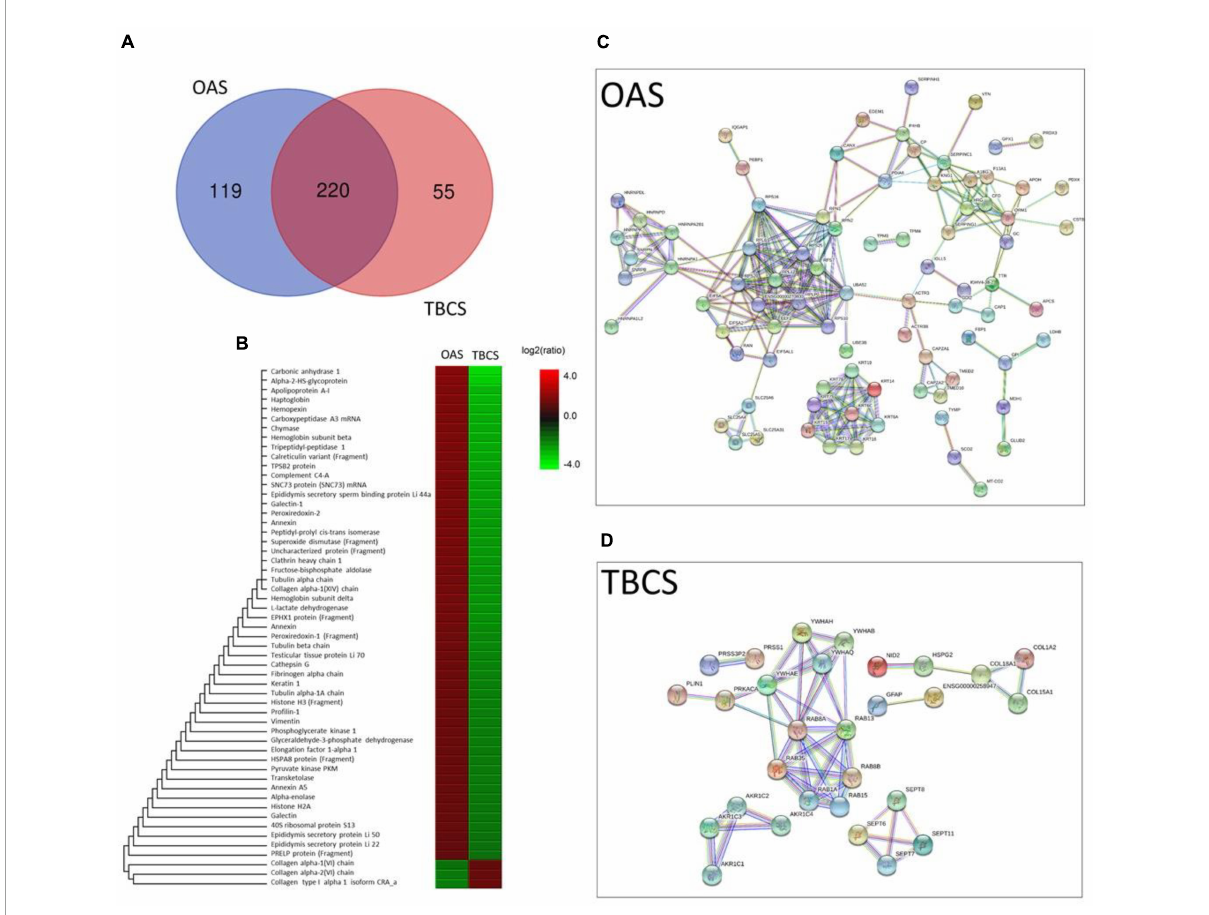
FIGURE2 The differential protein analysis in OAS and TBCS. (A) Venn diagram; (B) Heatmap of overlapped proteins expressed at different magnitudes; (C,D) STRING protein–protein interaction